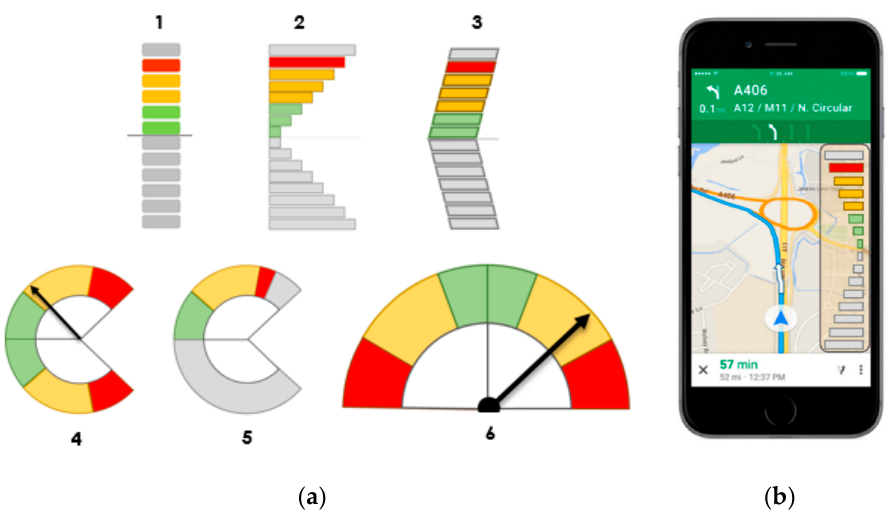
Figure 3. ( a ) Proposed interface alternative designs. ( b ) Example of the implementation in the smartphone of one of the alternatives.